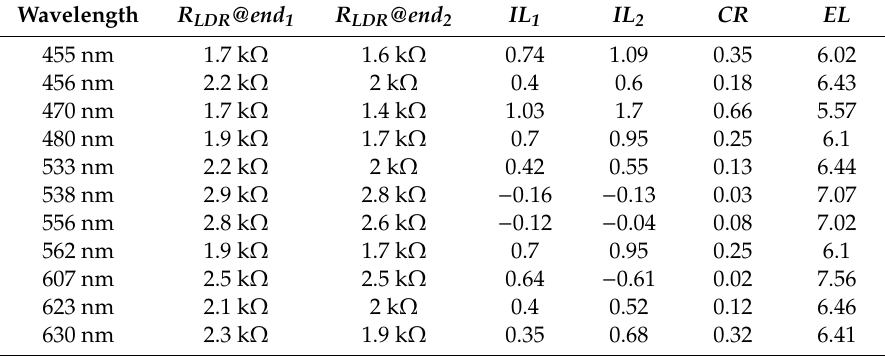
Table 1. Resistance values of light dependent resistor measured for di ff erent wavelengths of the sensor input, and the corresponding spectral attenuation measures: insertion loss (IL), coupling ration (CR) and excess loss (EL). Wavelength R LDR @end 1 R LDR @end